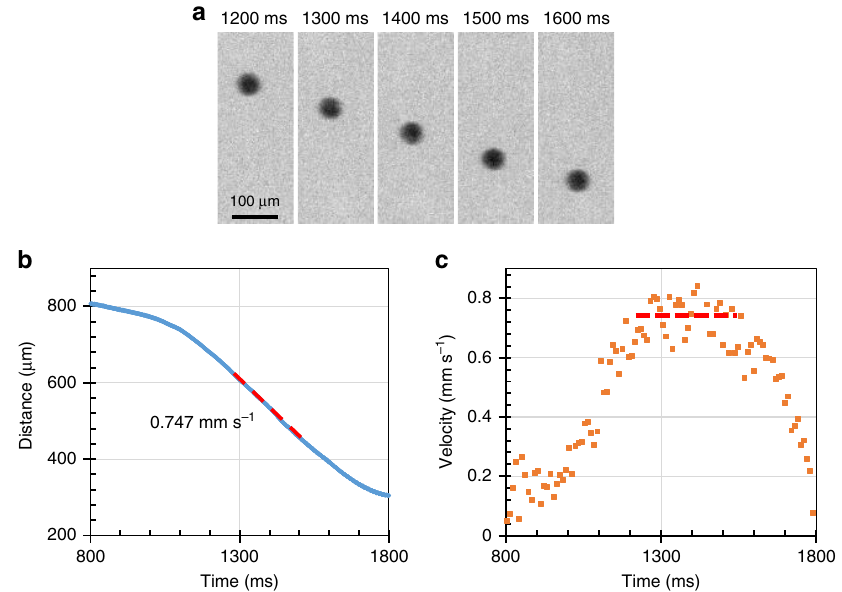
Fig. 1 Experimental observation of the falling sphere. a Sequential radiographic images recorded at ~24 GPa and ~2873 K during the fall of a Re-sphere of ~65 μ m diameter (Run MA24). b Position of the sphere as a function of time in Run MA24. The sphere position was fi tted by a Gaussian function in each X-ray radiographic image (blue symbol). The melt viscosity can be calculated from the terminal velocity (red dashed line) using Eq. (4). c Velocity/time plot of the sphere in Run MA24, using a sampling time of 10 ms. The red dashed line is a best fi t through the data points located on the "velocity plateau" corresponding to the terminal velocity.